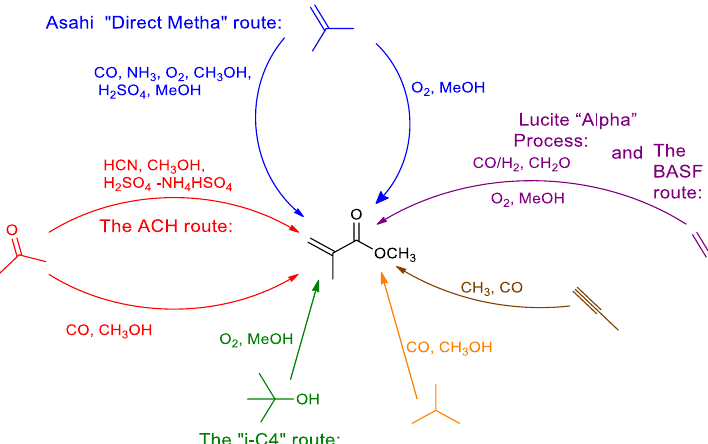
Figure 1. Commercial routes to methyl methacrylate and related acrylics.